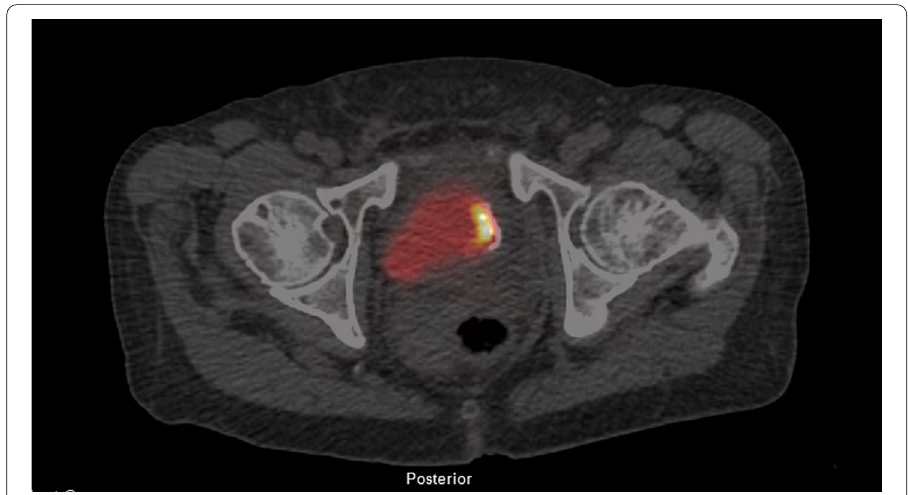
Fig. 1 Fused transaxial images of FDG PET/CT with intense FDG uptake in the left lateral urinary bladder wall (SUV max 67.9) and calcification, at the prior resected and treated =